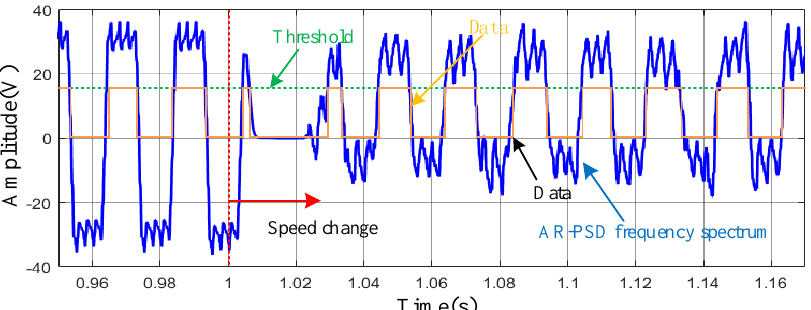
Figure 22. Frequency spectrum and demodulated data as the speed is changed from 1000 r/min to 800 r/min.